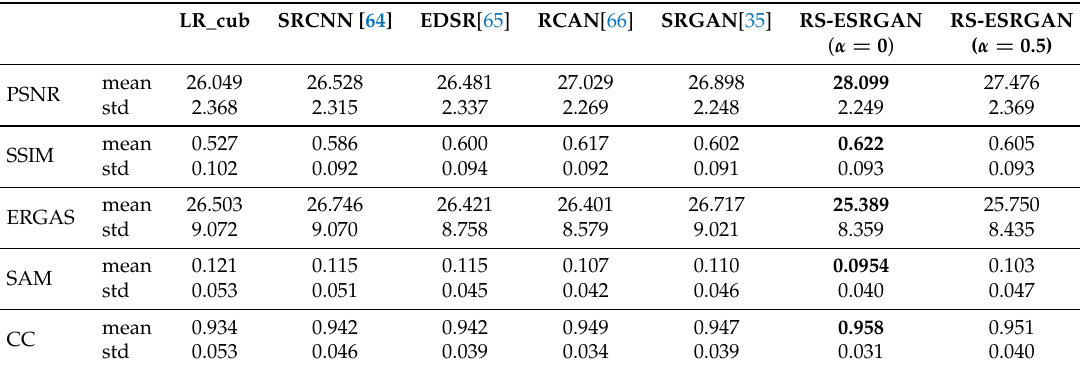
Table 6. Quality metrics results on W-S Set1 for different methods.